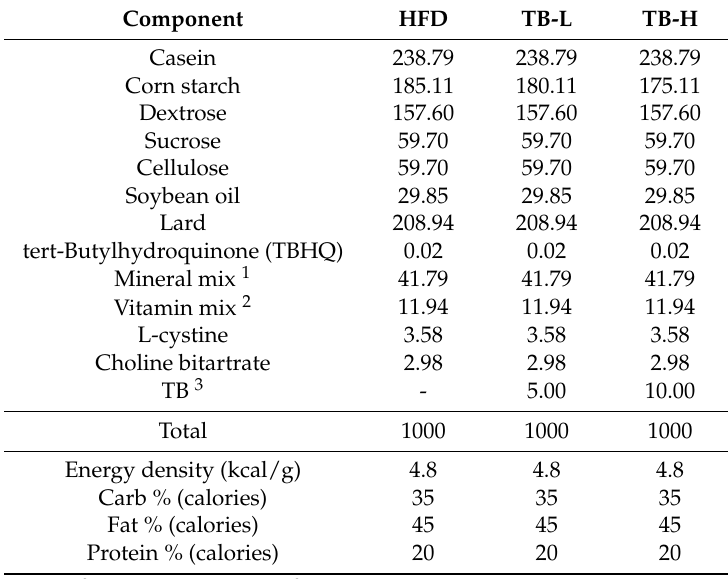
Table 1. The compositions of experimental diets (g/kg diet). Component